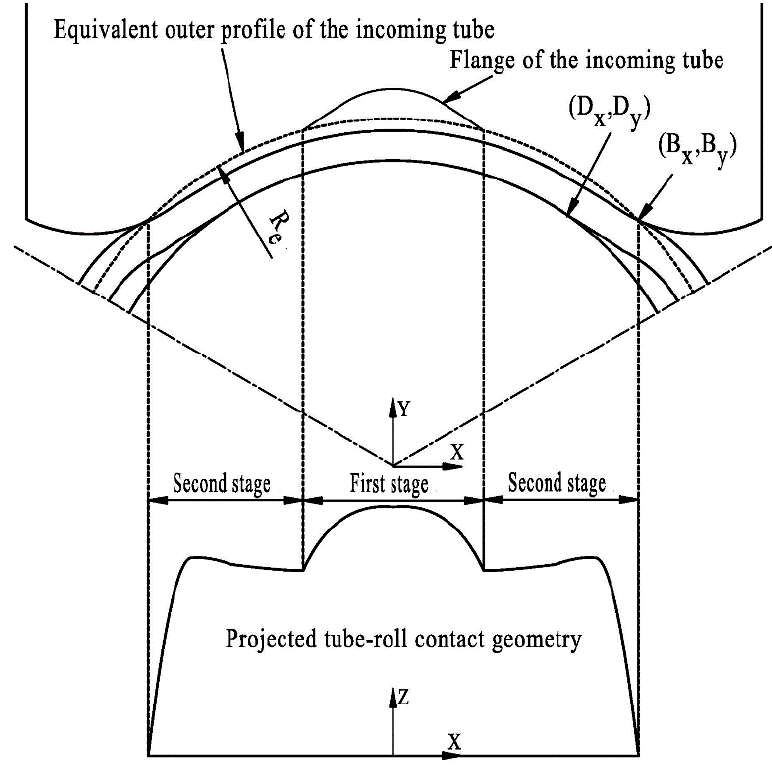
Figure 1. The two assumed formation stages of the tube-roll contact boundary. Since the tube profile and the roll groove profile are composed of circular arcs, the so- lution for the tube-roll contact geometry can be transformed into a space analytic geometry problem. For the contact boundary formed corresponding to the first stage (see Figure 2), the projected contact length L at a given x-coordinate can be calculated as follows: